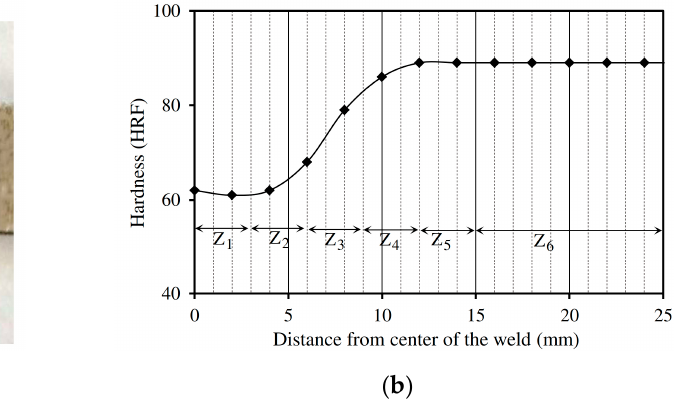
Figure 2. HAZ subzones: ( a ) subzones on the specimen, ( b ) hardness curve of the welded specimen [25].